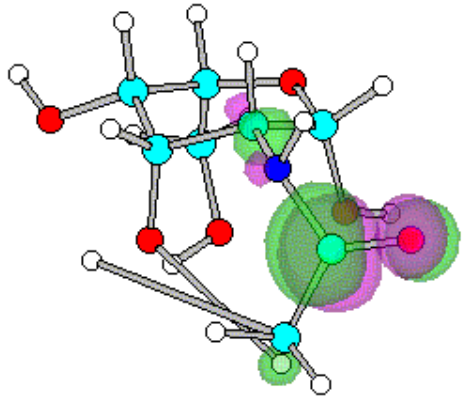
Figure 5. Optimized geometry and spatial distribution of LUMO for N-acyl-AG (2).